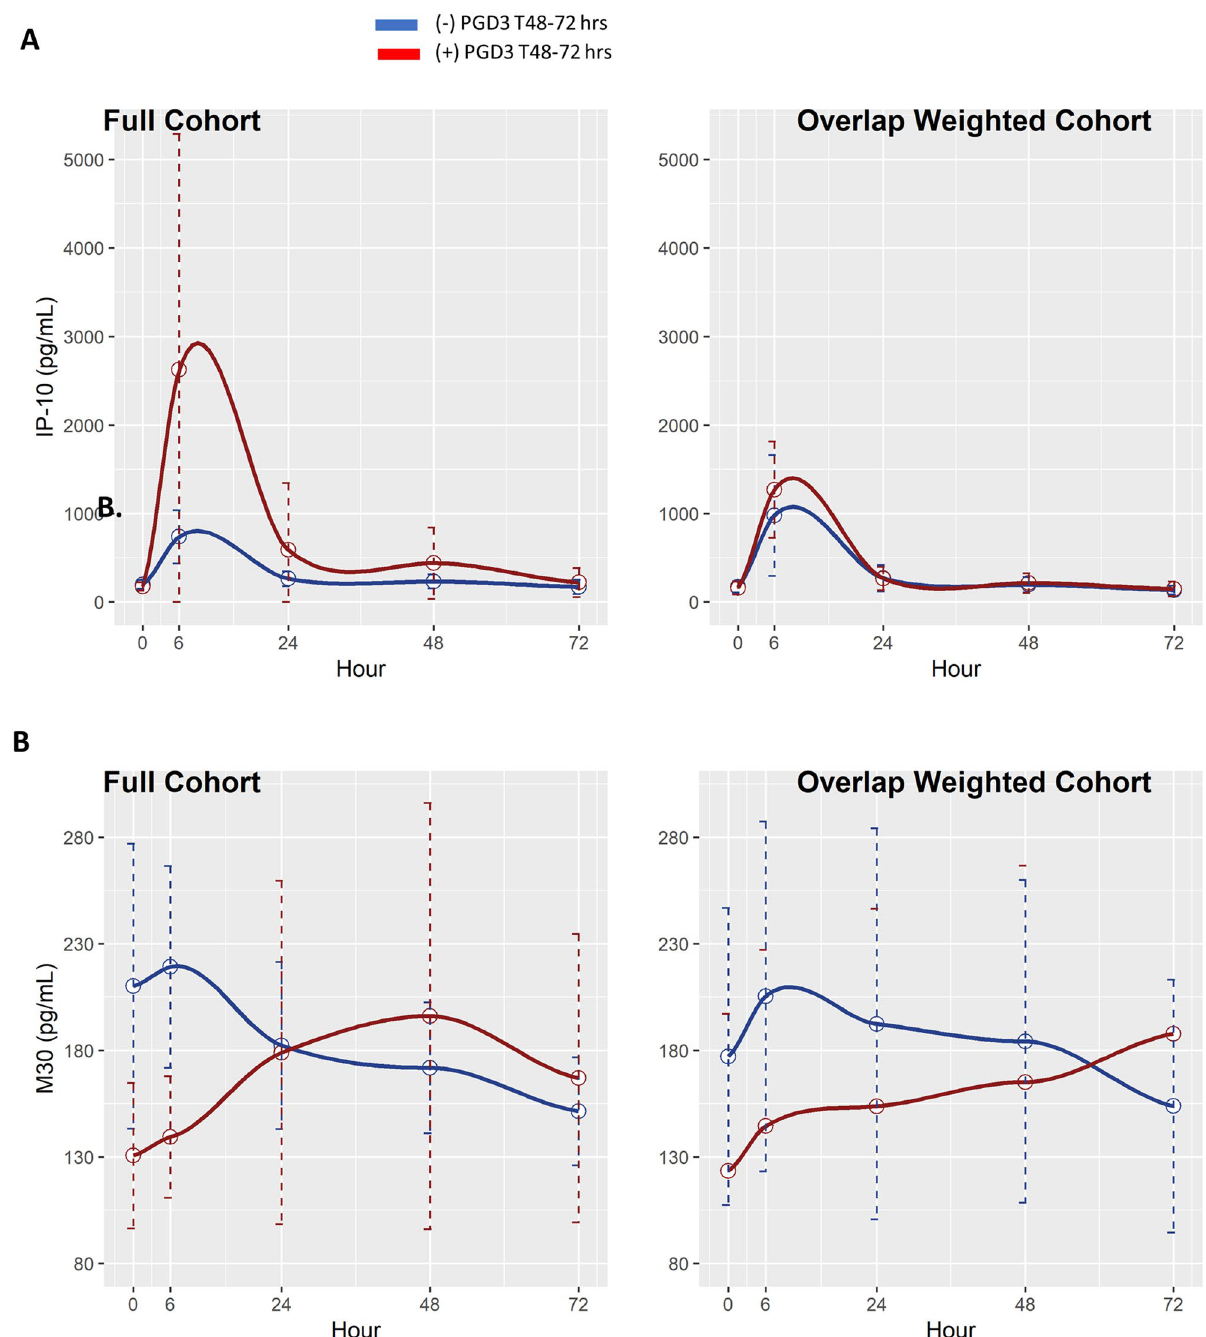
Figure 4. Temporal analysis. Differences in evolution for circulating biomarkers in patients with (red) or without (blue) PGD3 at T48–72 h in the full and overlap weighted cohort are shown. The overlap weighted cohort was adjusted for the following factors: BMI, hypertension, type of transplant, EVLP, and type of ECLS. ( A ) Interferon γ-induced protein (IP)-10 and ( B ) M30. Circles represent the average biomarker level at respective time points; dotted lines represent 95% confidence intervals for the biomarker level at respective time points. The image was created using R software version number 4.1.3 (https:// cran.r- proje ct.